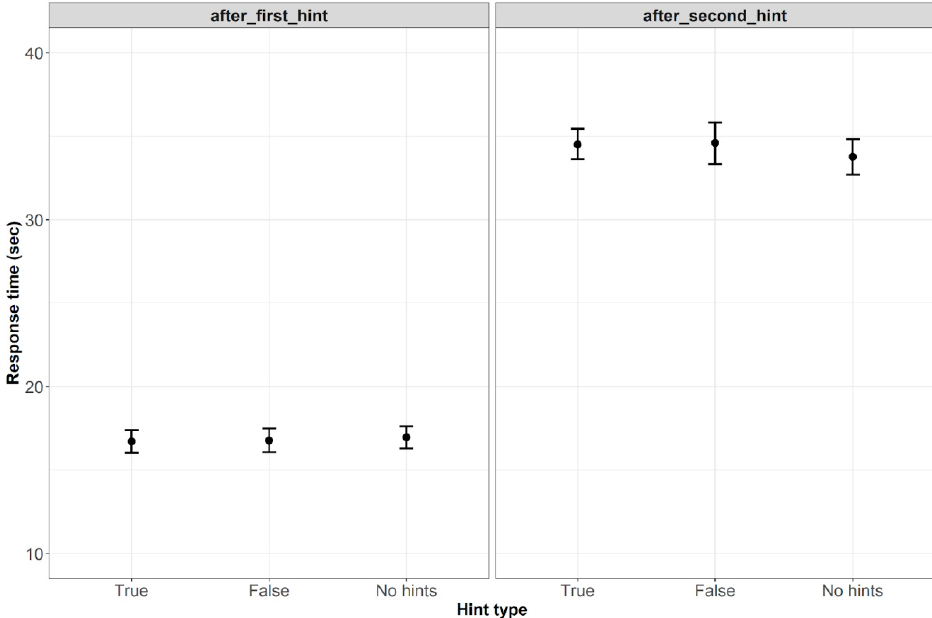
Figure 2. Average response times for correct solutions obtained after the first and the second hints (Bars refer to 95% confidence intervals).